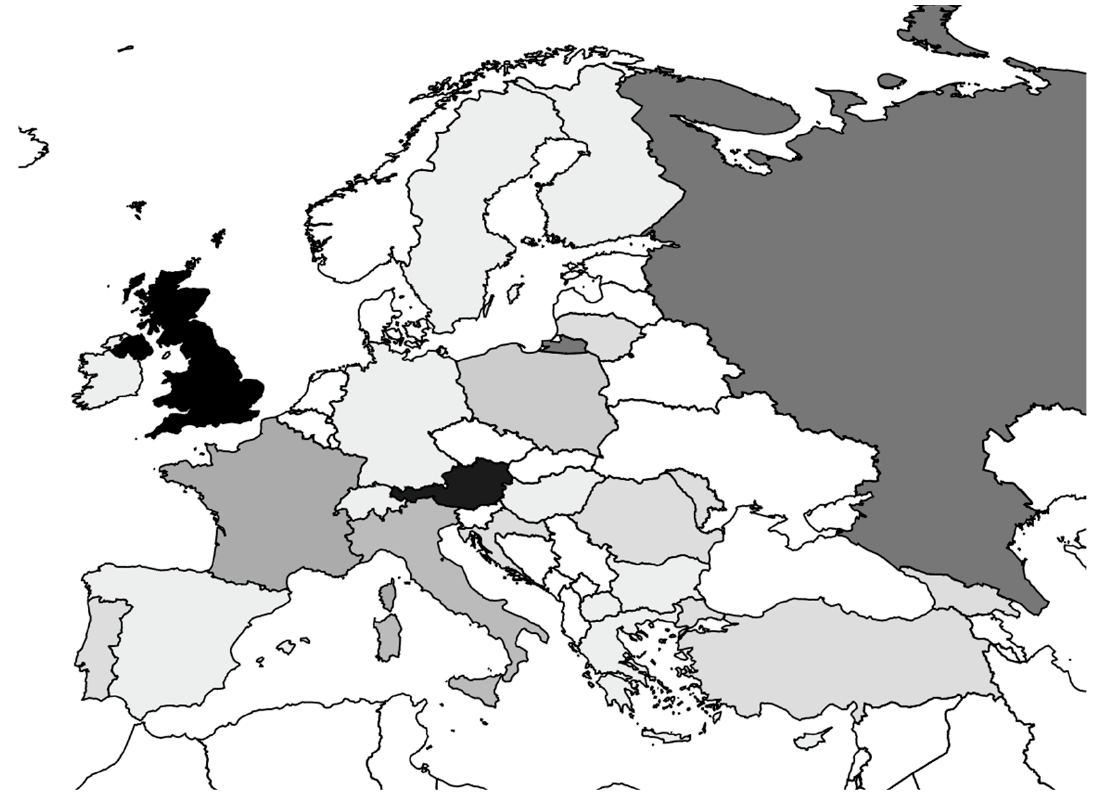
Figure 2. Overview of the states the analyzed cases arise from; the darker the state is colored, the more cases deriving from this state have been found.